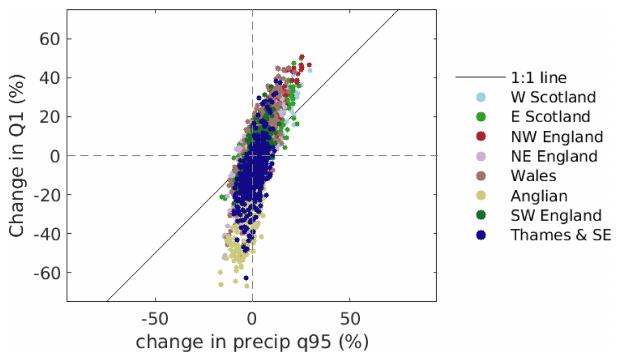
Figure 8. Relationship between precipitation change and Q1 change across all catchments. Results are presented for all RCMs using the median of all hydrological parameter sets.